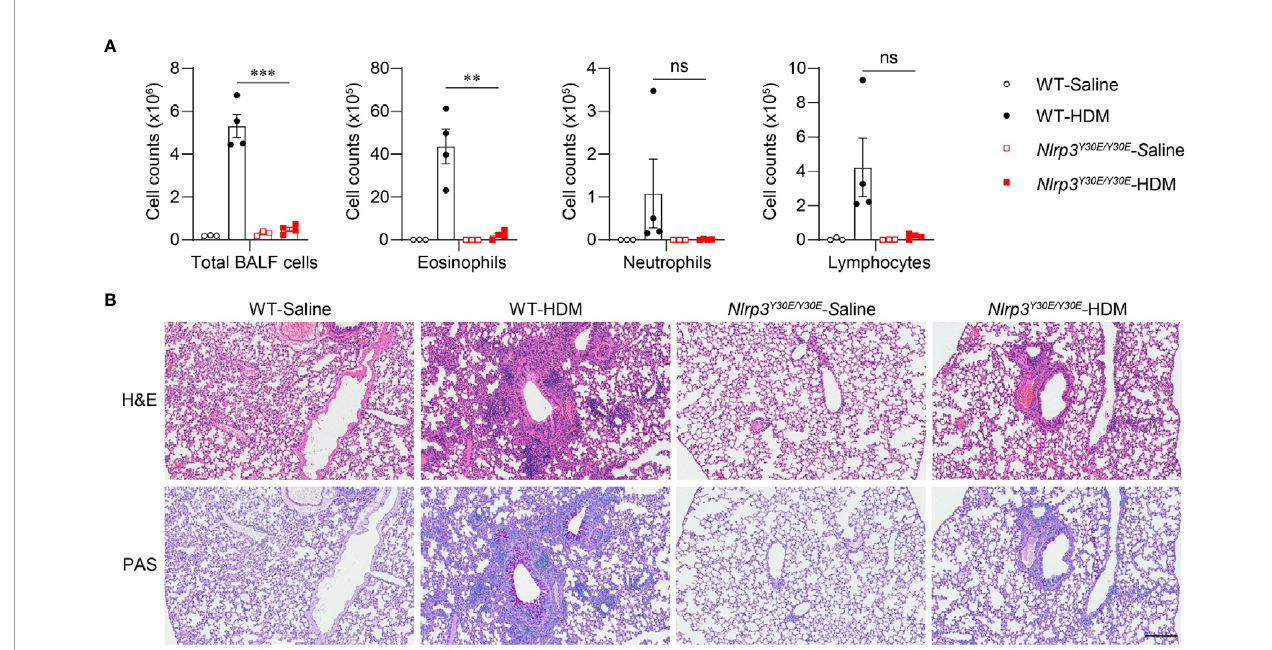
FIGURE 4 | Nlrp3 Y30E/Y30E mice have attenuated in fl ammation in HDM-induced asthma. (A, B) WT and Nlrp3 Y30E/Y30E Mice were sensitized and challenged with 10 m g HDM i.n. on day 0 and days 7-11. The mice in control group were sensitized and challenged by inhaling saline. On day 14, all mice were euthanized for analysis. (A) Counts of total BALF cells, eosinophils, neutrophils and lymphocytes; n = 4 biologically independent mice. (B) Histological analysis of lung sections stained with H&E and PAS (Scale bar = 200 m m); n = 3 biologically independent experiments. Statistical signi fi cances were analyzed by unpaired Student ’ s t -test: ** P < 0.01, *** P < 0.001, ns (not signi fi